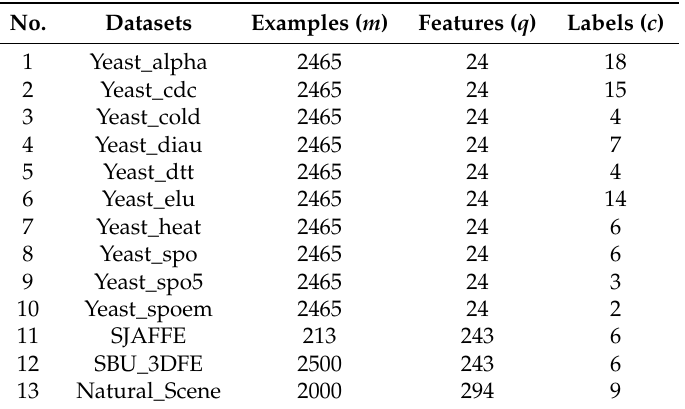
Table 1. Datasets used in